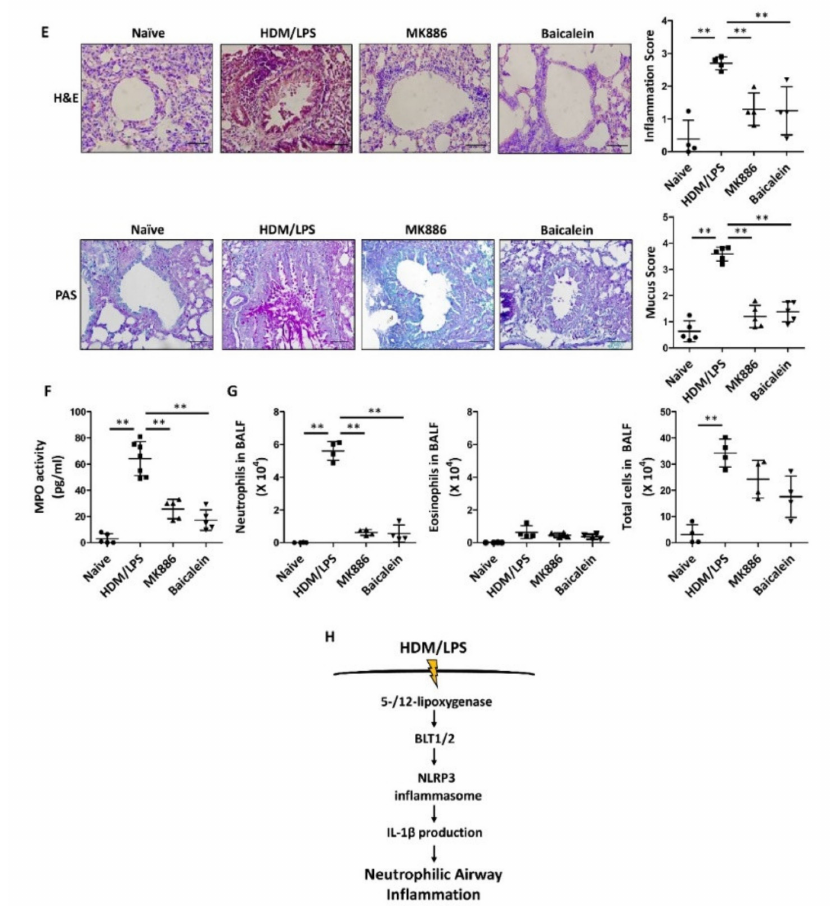
Figure 4. 5/12-lipoxygenase are necessary for NLRP3 stimulation and IL-1 β production in HDM/LPS-induced neutrophilic airway inflammation. The control DMSO, MK886 (5 mg/kg) and baicalein (75 mg/kg) were administered via i.p. injection 1 h before every challenge. Naïve designates control without any additions. ( A ) Levels of IL-1 β , LTB 4 and 12(S)-HETE in lung lysates were analyzed using ELISA. Data are shown as the mean ± SD ( n = 5–7 per group). ( B , C ) The mouse lungs were homogenized, protein was isolated, and the levels of 5-/12-LOX, NLRP3, ASC and caspase-1 were assessed by Western blotting. Data are representative of three independent experiments with similar results. Quantification of NLRP3 and caspase-1 was provided by image J. ( D ) Immunofluorescence staining for NLRP3 (red, CY TM 3) in lung tissues. Nuclei were stained with DAPI (blue) (400 × ). The images are representative of three independent experiments with similar results. ( E ) The lungs were excised, fixed, and stained with H&E and PAS. Peribronchial and perivascular lung inflammation were measured and scored (400 × ). Data are shown as the mean ± SD ( n = 4 per group). ( F ) Levels of MPO in lung lysates were analyzed using ELISA. Data are shown as the mean ± SD ( n = 5–7 per group). ( G ) Neutrophils, eosinophils, and total immune cells in BALF were obtained using Cytospin and stained with Diff-Quik. Data are shown as the mean ± SD ( n = 4 per group). ( H ) Scheme of the ‘5/12-LOX-BLT1/2-NLRP3 inflammasome-IL-1 β ’ signaling cascade in HDM/LPS-induced neutrophilic airway inflammation. All experiments were performed in triplicate. * p < 0.05, ** p < 0.01 versus each control